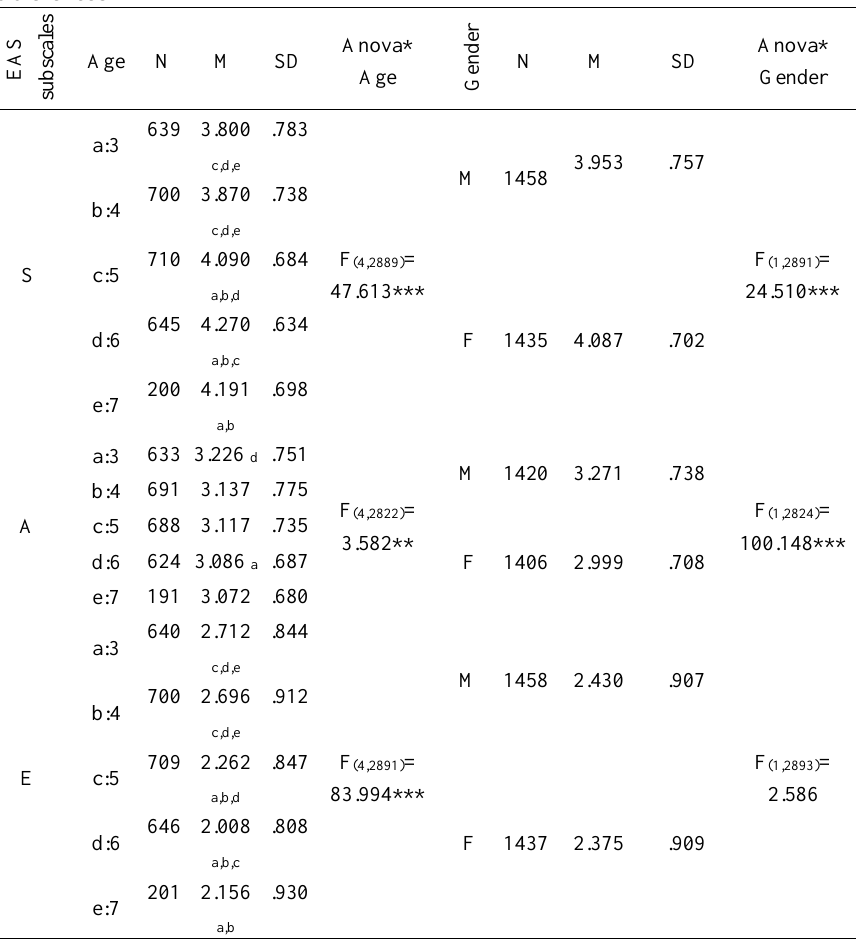
Main effects of age and gender differences in relation to Sociability (S), Activity (A) and Emotionality (E): ANOVA results and Scheffe test for inter-group age